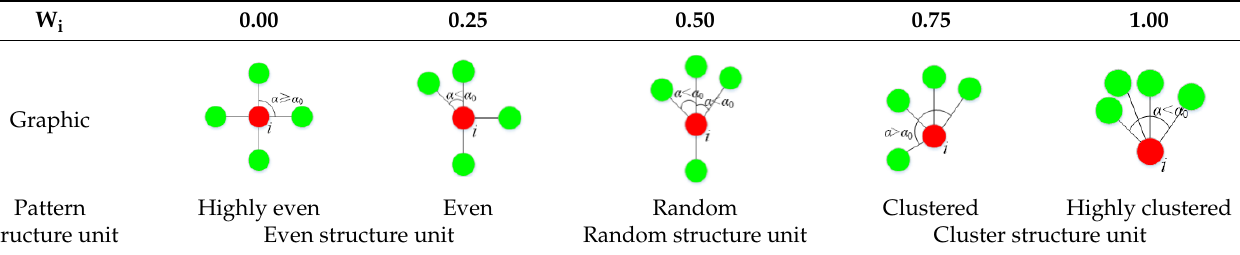
Table 1. The values and meanings of the uniform angle index.